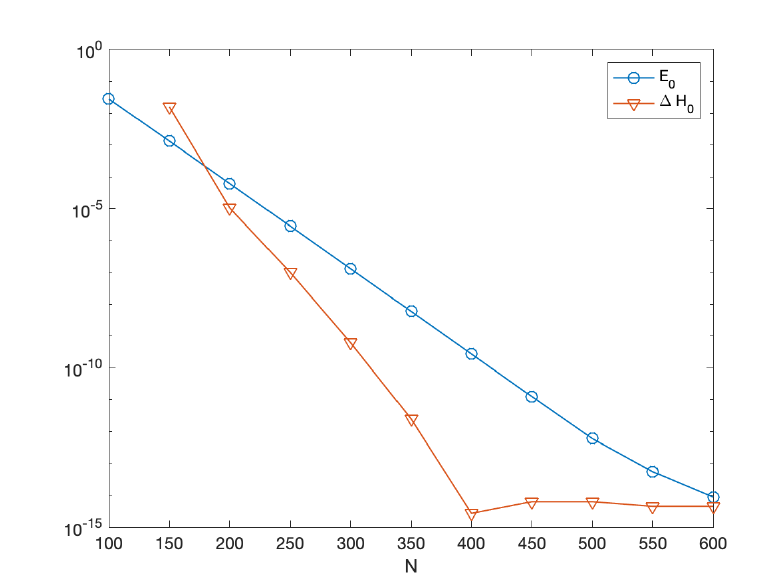
Figure 2. Nonlinear Schrödinger Equation (94); upper plot: modulus of the solution (95); lower plot: E 0 (see (89)) and ∆ H 0 (see (91)) versus N